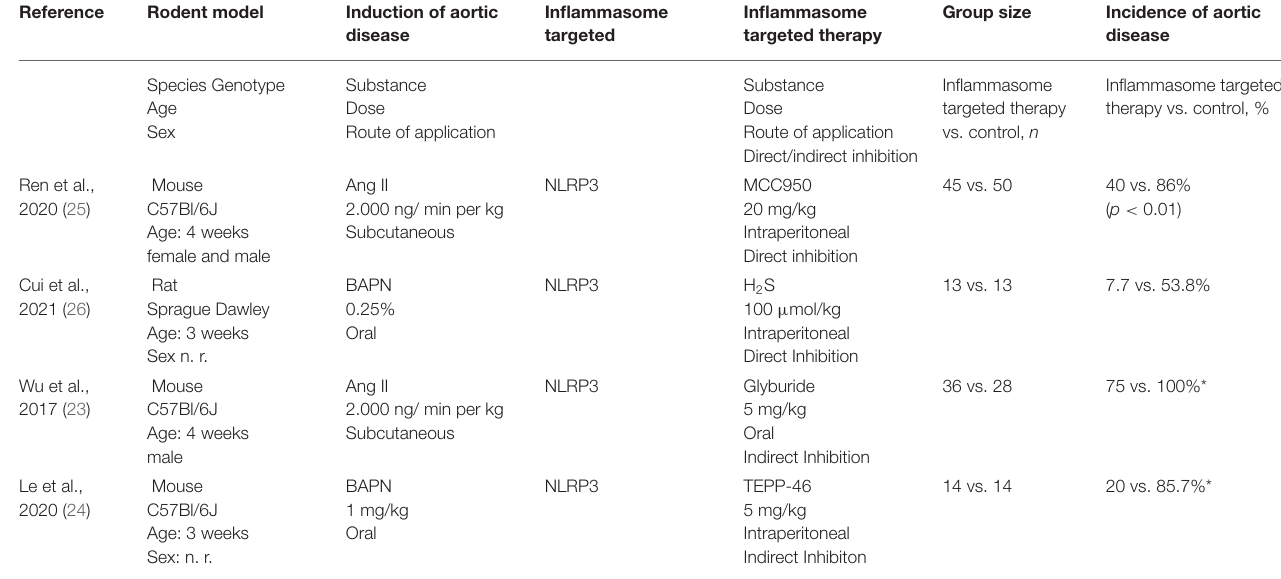
TABLE 1 | Characteristics and main results of the four included studies (n. r.: not reported, * approximately values, exact numbers not reported).